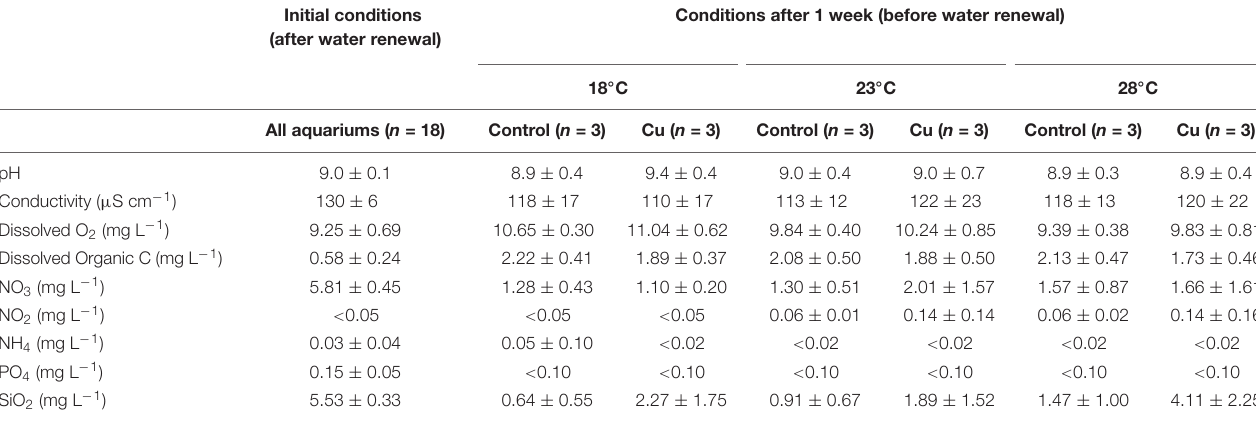
TABLE 1 | Physico-chemical characteristics of water in the six tested conditions before (conditions after 1 week) and 2 h after (initial conditions) each water renewal during 4 weeks (mean values of weekly samples ± SD; n = 3). Initial conditions (after water